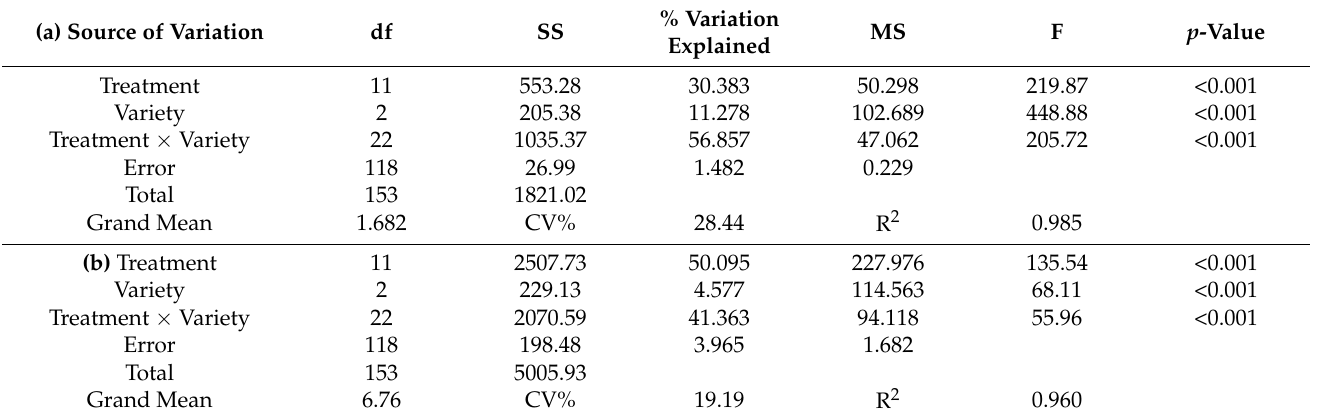
Table 5. Effect of treatments and genotypes and their interaction on shoot length (a) and number of shoots (b) during